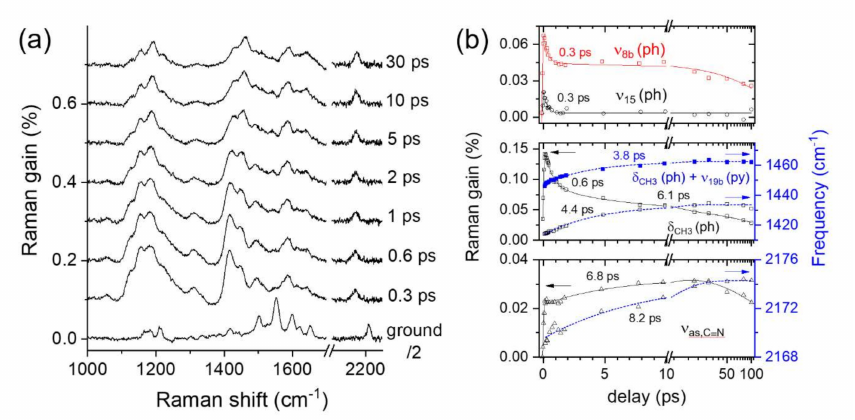
Figure 3. ( a ) Femtosecond stimulated Raman spectra of DCM in CHCl 3 solution with 403 nm excitation and ( b ) the population and structural dynamics of ν 15 (ph) at 1057 cm − 1 and ν 8b (ph) at 1495 cm − 1 ; − 1 ; ν − 1 . All the + ν δ δ CH3 (ph) at 1415–1428, CH3 (ph) 19b (py) at 1448–1462 cm as,C ≡ N at 2171–2174 cm kinetic traces were fit with a number of exponential functions convoluted with a Gaussian function for the instrument response function of the experiment. Solid and dotted lines represent the fit results for the population and structural dynamics, respectively. The “ph” and “py” denote the phenyl and pyran ring,